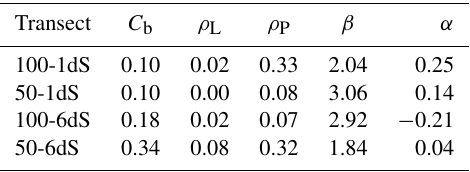
Table 1. Concordance parameters for the four transects for the TDR_ORG and EMI_ORG data. The table reports the concordance, ρ L , and the Pearson, ρ P , correlation, as well as parameters α and β of the MRA line. The bias factor, C b , is also shown. Transect C b ρ L ρ P β α 100-1dS 0.10 0.02 0.33 2.04 0.25 50-1dS 0.10 0.00